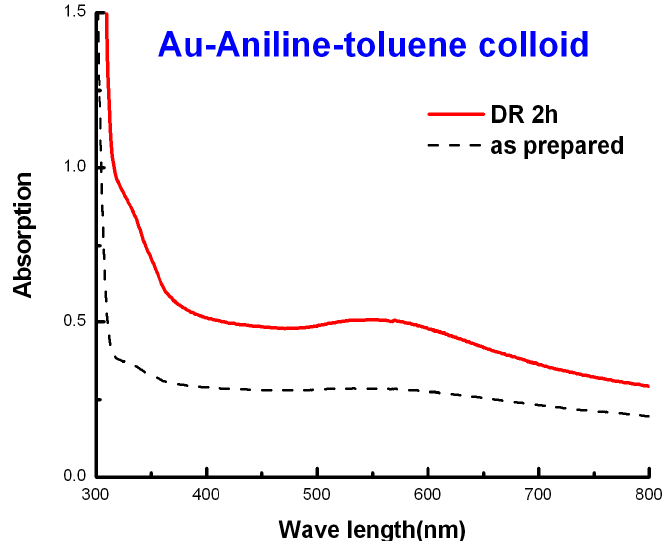
Figure 18. UV-Vis spectrum of Au-aniline colloids before and after digestive ripening 2 h in